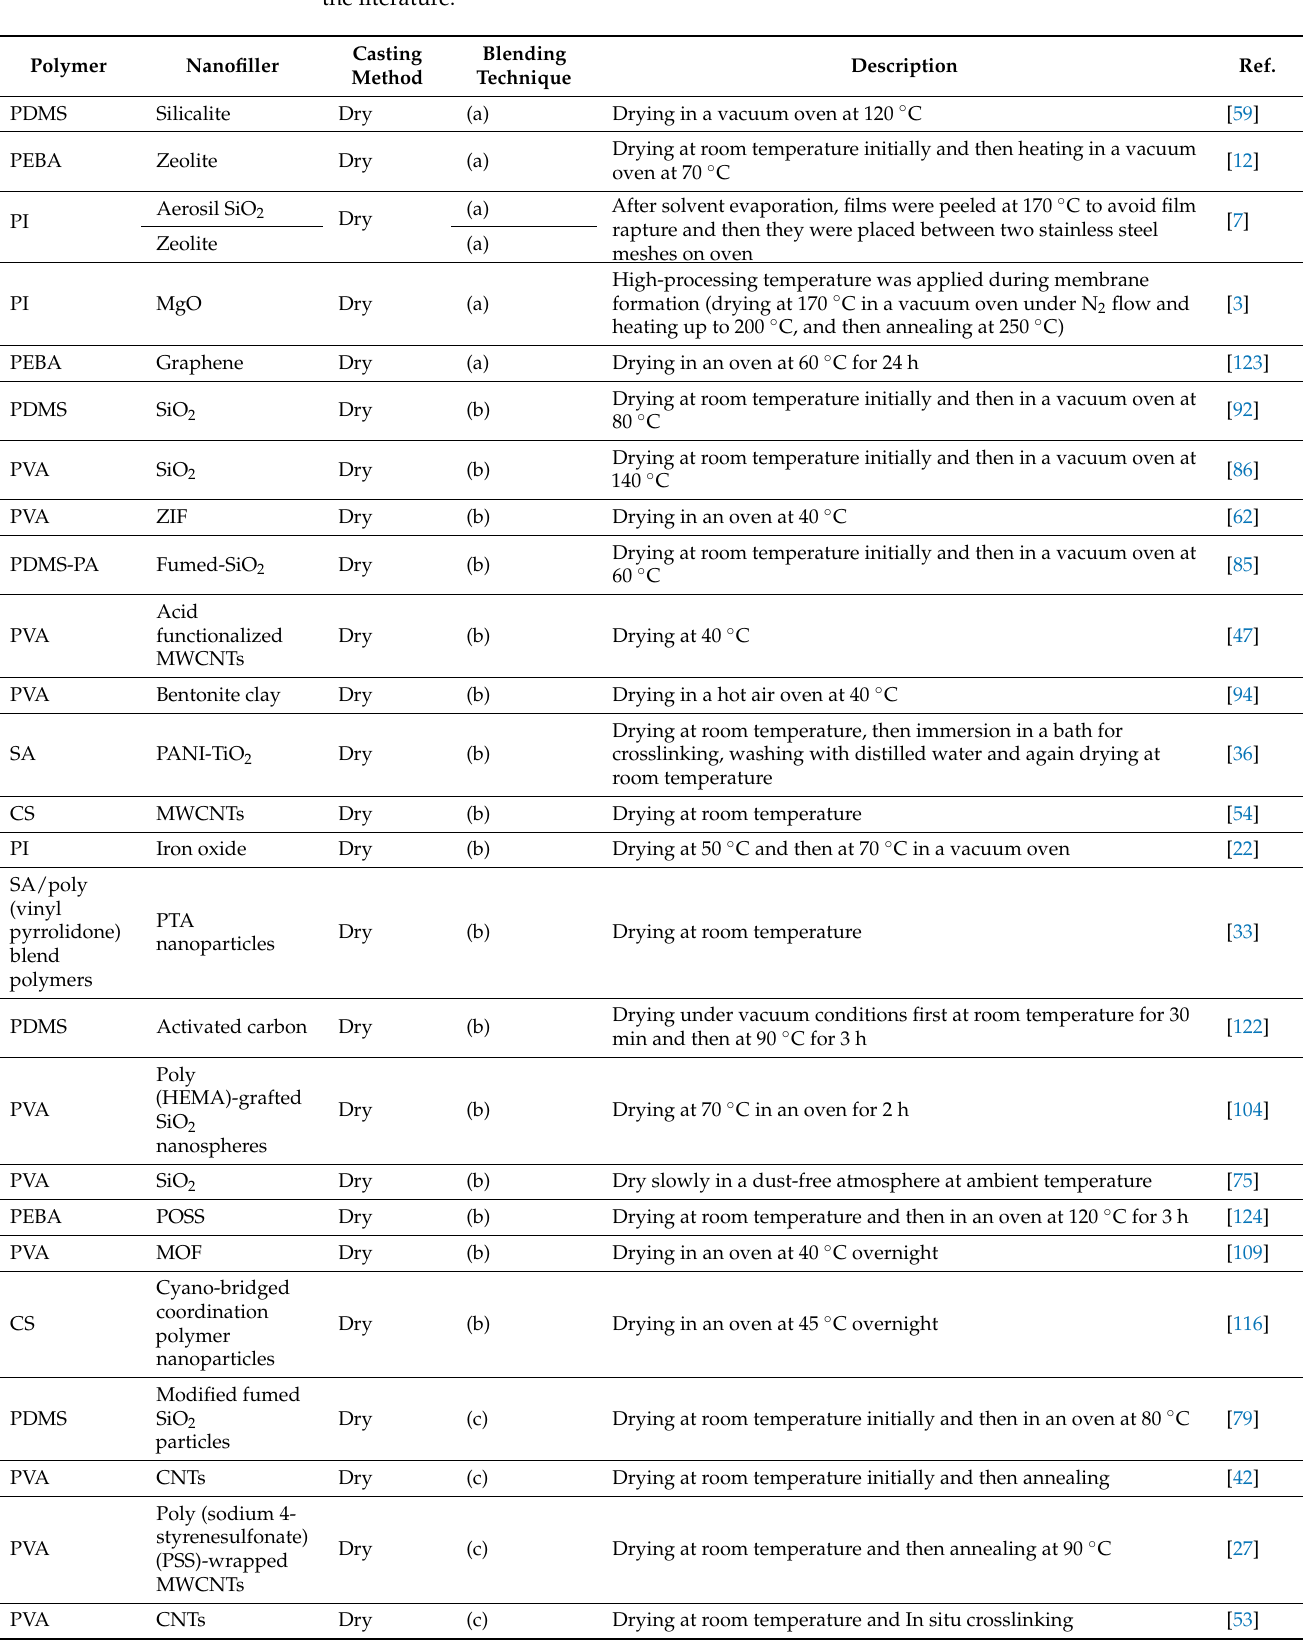
Table 2. PV nanocomposite membranes prepared using the solution blending method reported in the